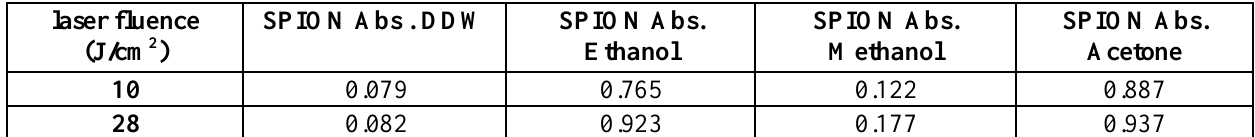
Table 4: Optimal values of absorbance for SPIONs NPs with different laser fluences at wavelength 266 nm.